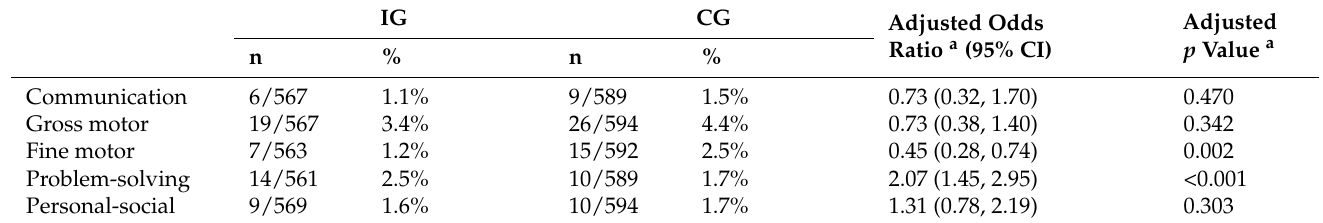
Table 4. Proportion of children with ASQ scores below cut-off at 3 years of